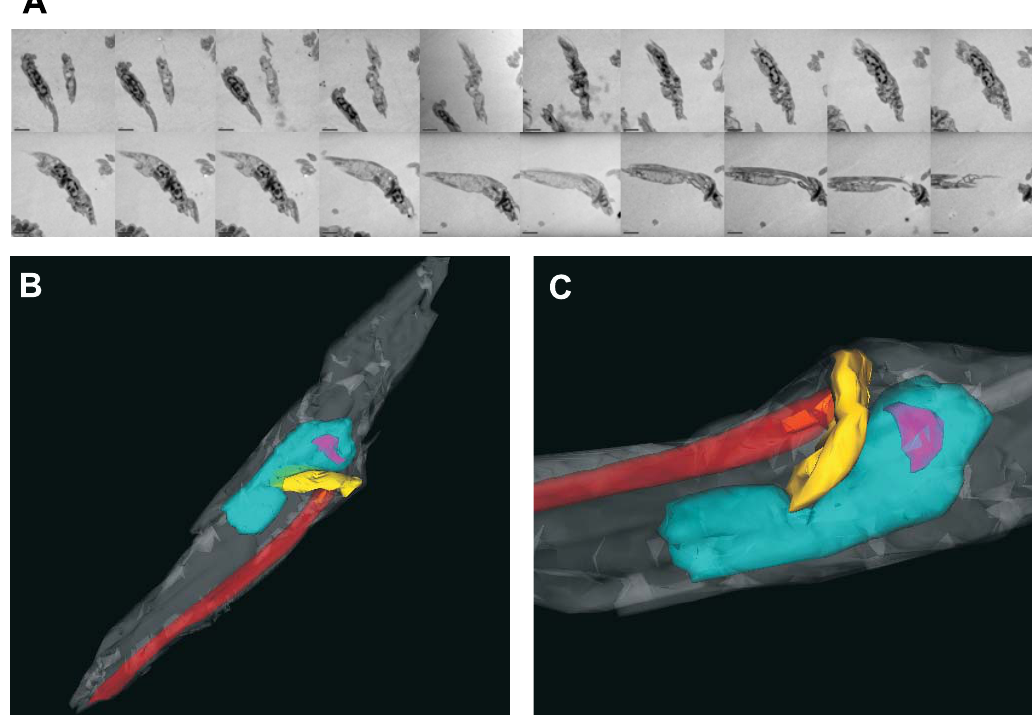
Fig. 5 – Three-dimensional reconstruction of T. cruzi undergoing metacyclogenesis. Panel A shows serial sections of one intermediate stage, isolated 48 hours after stress induction. Panel B and C show cell body (gray), the flagellum(red), thekinetoplast(yellow), thenucleus(blue)andthenucleolus(violet)obtainedafterthree-dimensional reconstruction of the sections shown in A. The cell body, the nucleus and flagellum were made in transparent colors to visualize the internal structures, particularly the base of the flagellum shown in